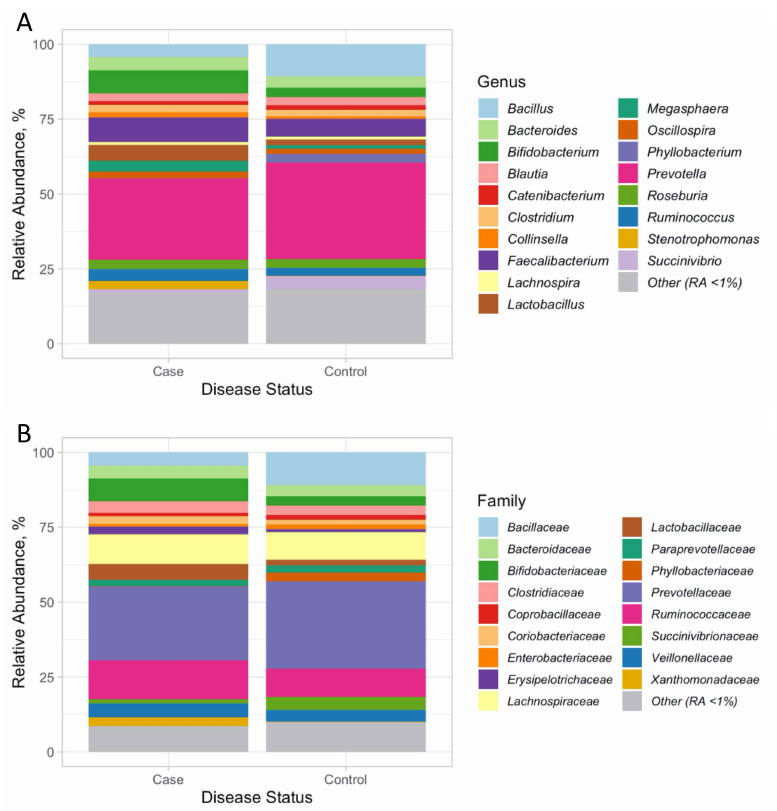
Figure 1. The relative abundancies (RA) of the OTUs at the ( A ) genus and ( B ) family level. For better visualisation, only OTUs with RA > 1% are plotted and the less prevalent ones are grouped together in Other (RA <